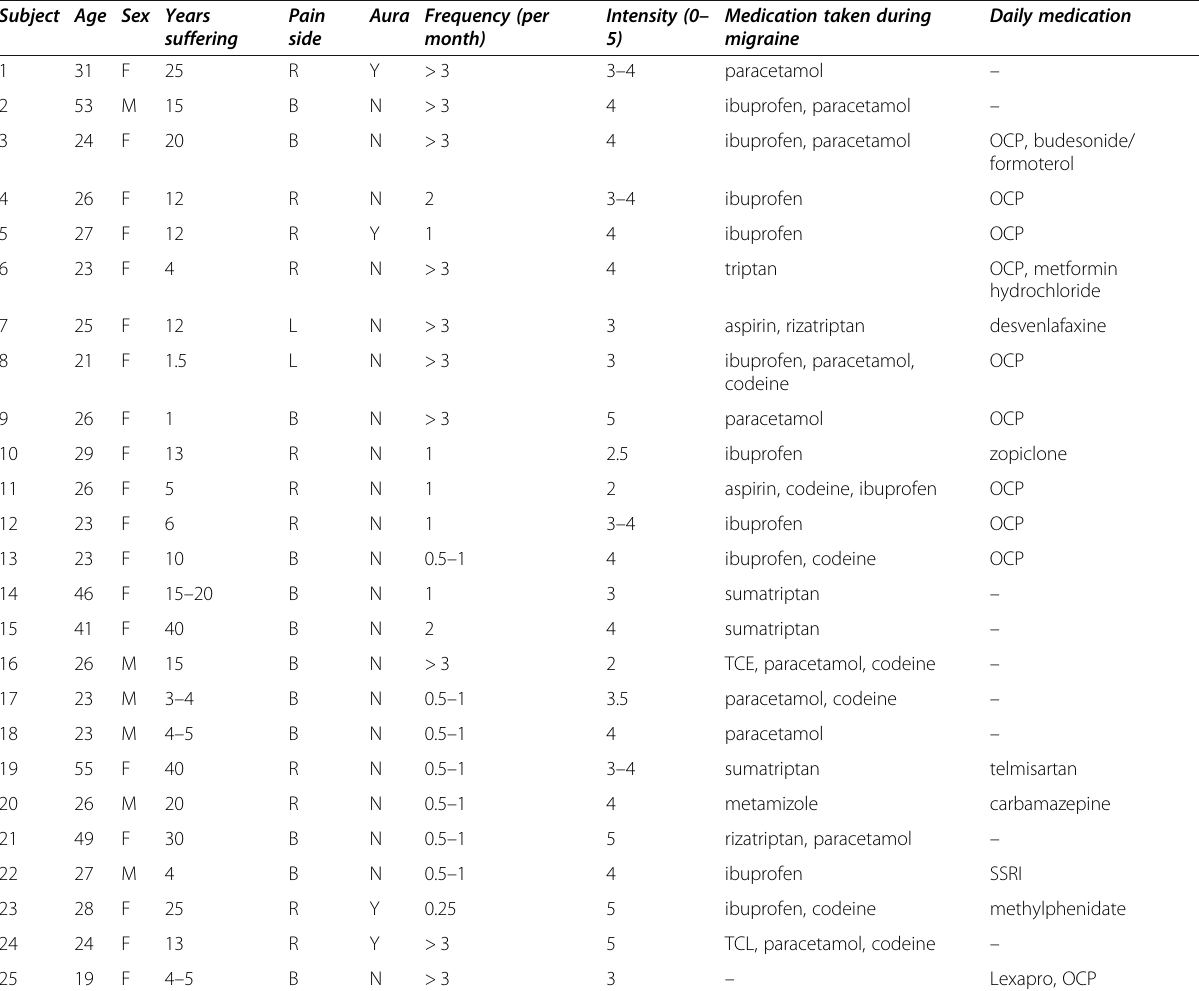
Table 1 Migraine subject characteristics. M: male; F: female; B: bilateral; L: left; R: right; OCP: oral contraceptive pill Subject Age Sex Years